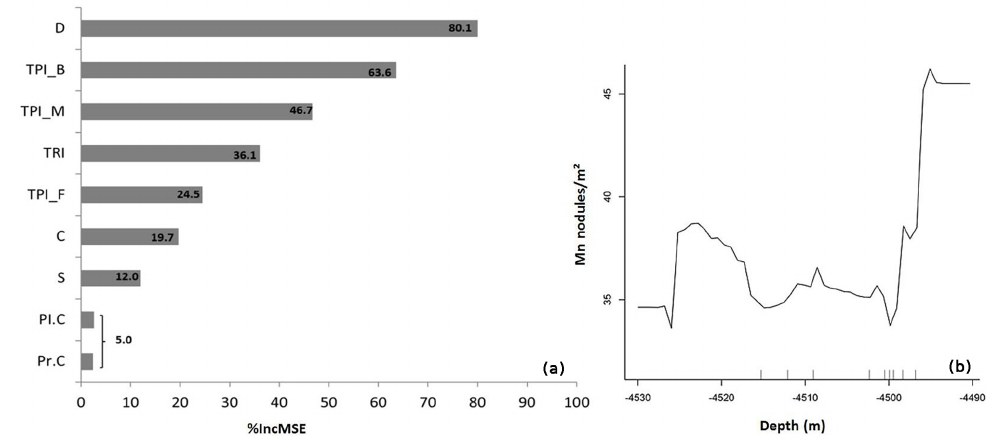
Figure 14. (a) The variable importance of each predictor in the RF model. (b) The partial dependence plot of depth. The ticks on the graphs indicate the deciles of the data.